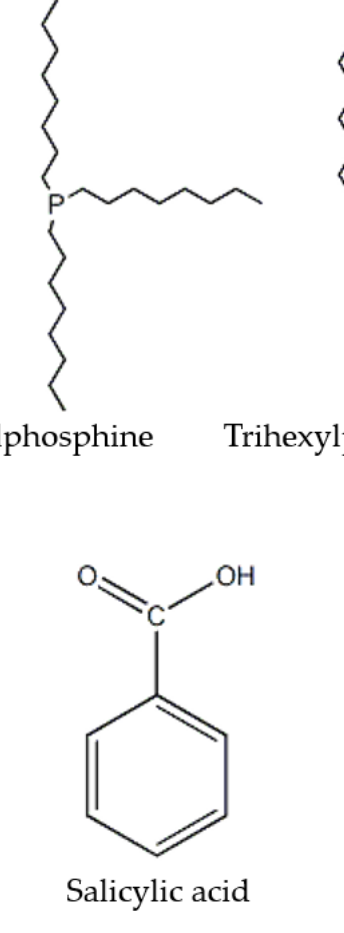
Figure 4. HBA and HBD making up the different DESs.